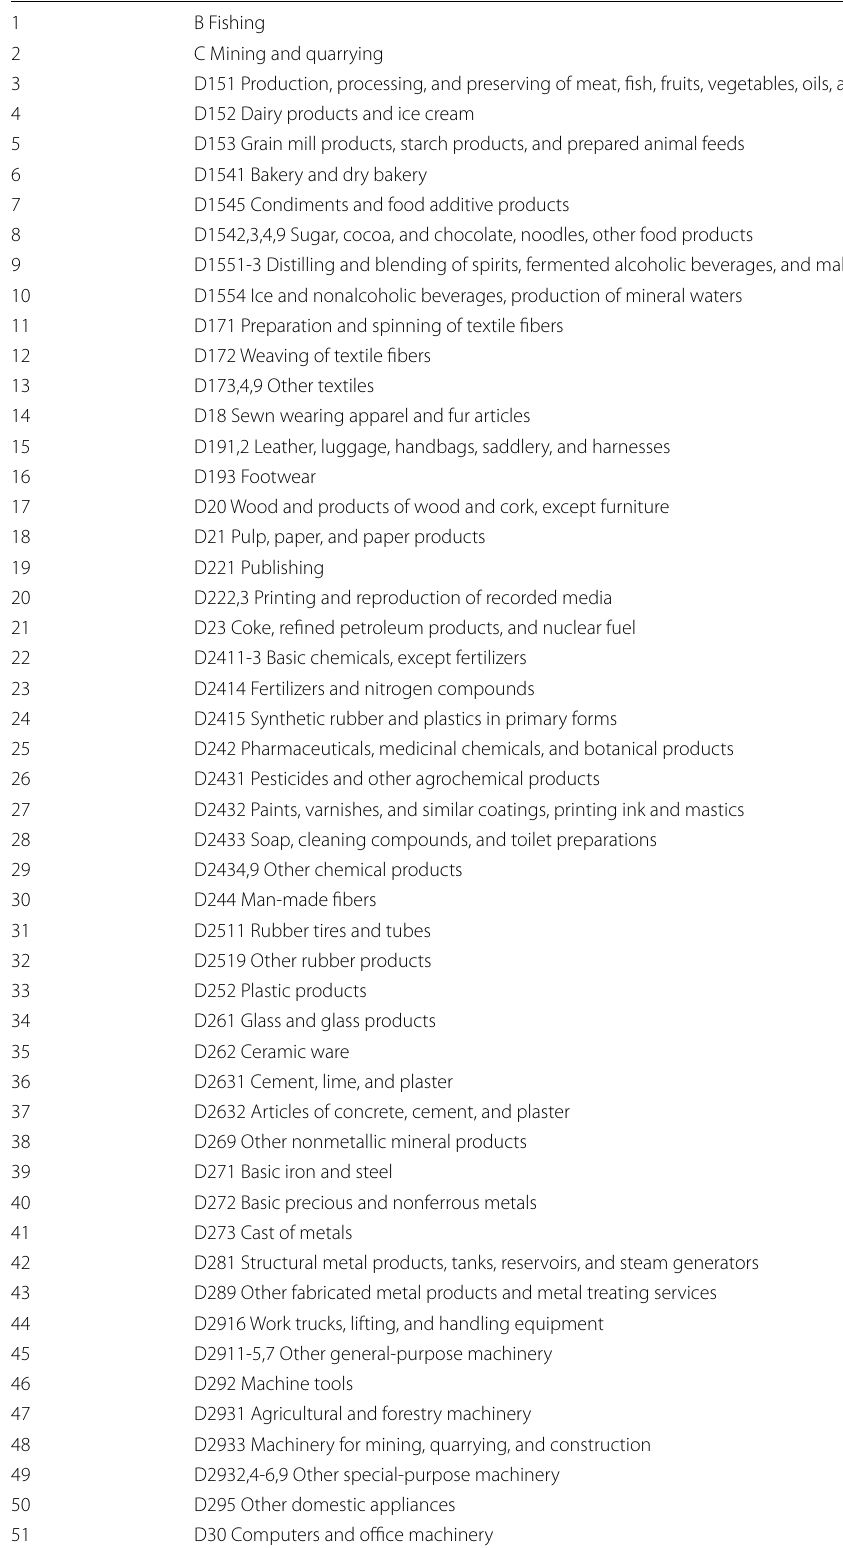
Table 4 Industries in the FSA